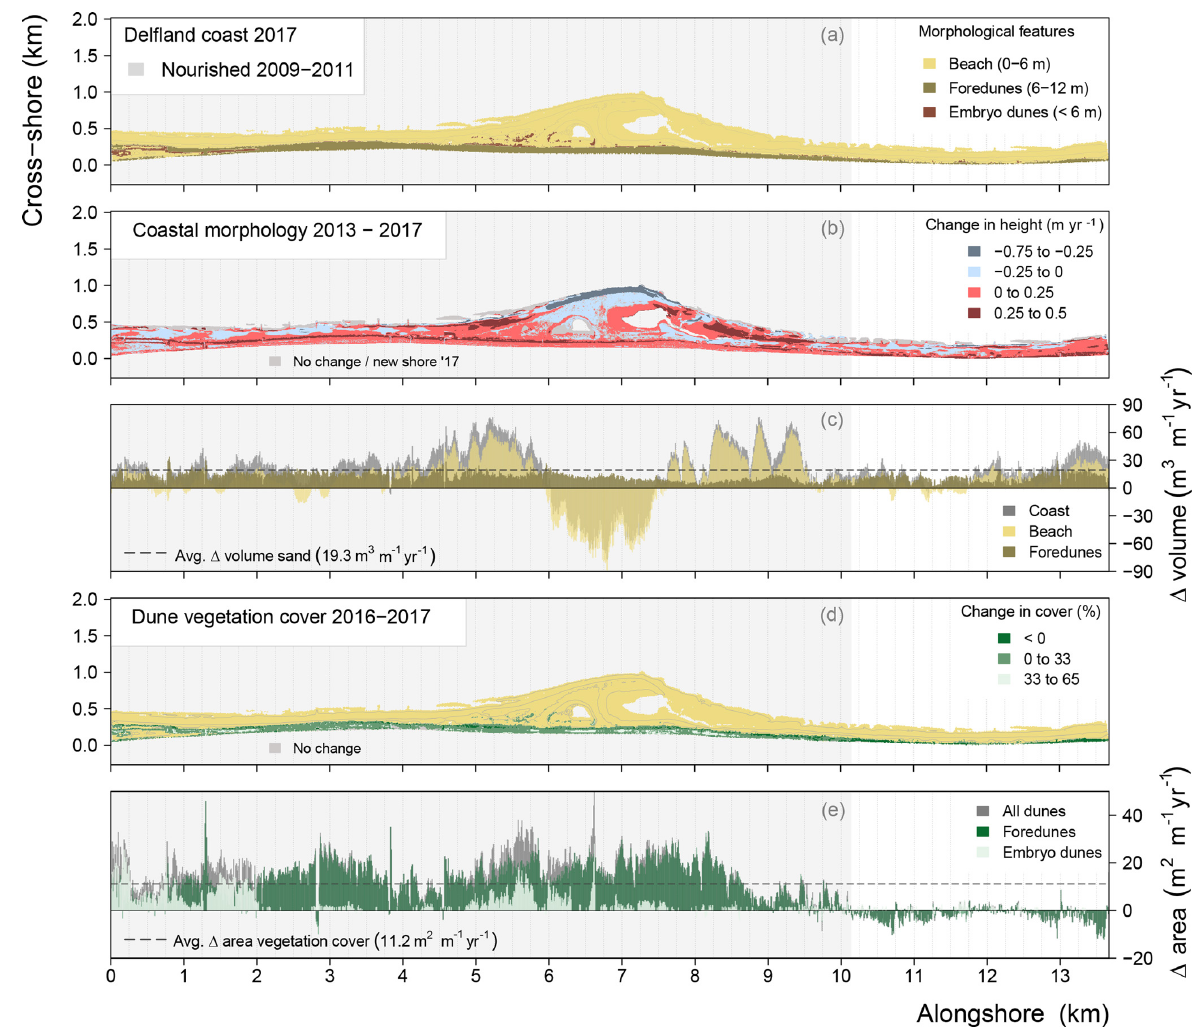
Figure 4. Morphological changes and dune vegetation-cover dynamics of the Delfland coast. (a) Map of the considered domain including the relevant morphological features (beach, foredunes, embryo dunes) in 2017. (b) Map of subaerial coastal morphological changes between 2013 and 2017, expressed average change in height per year (myr − 1 ). (c) Average alongshore changes in coastal sand volumes (m 3 m − 1 yr − 1 ) between 2013 and 2017 for the Delfland coast and differentiated by the beach (embryo dunes included) and foredunes. (d) Map of changes in dune cover by marram grass between 2016 and 2017, expressed as percentage per 10m pixel. (e) Alongshore changes in marram grass dune cover (m 2 m − 1 yr − 1 ) between 2016 and 2017, with differentiation between the foredunes and embryo